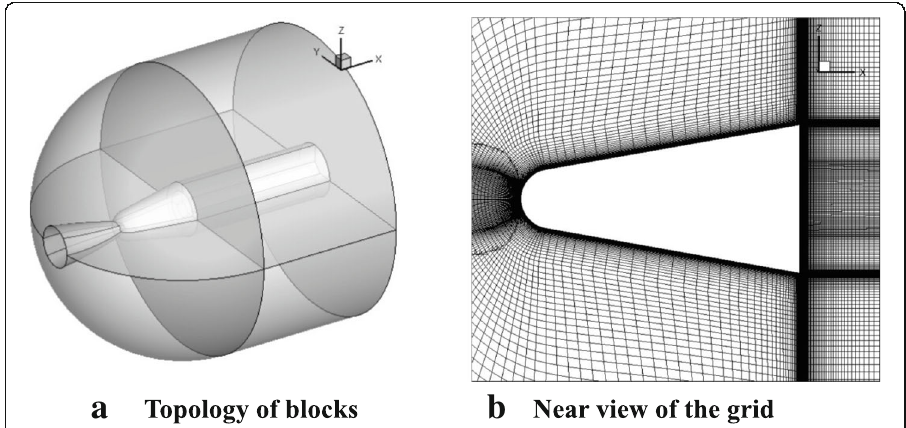
Fig. 8 The refined grid considering the bottom regions. a Topology of blocks. b Near view of the